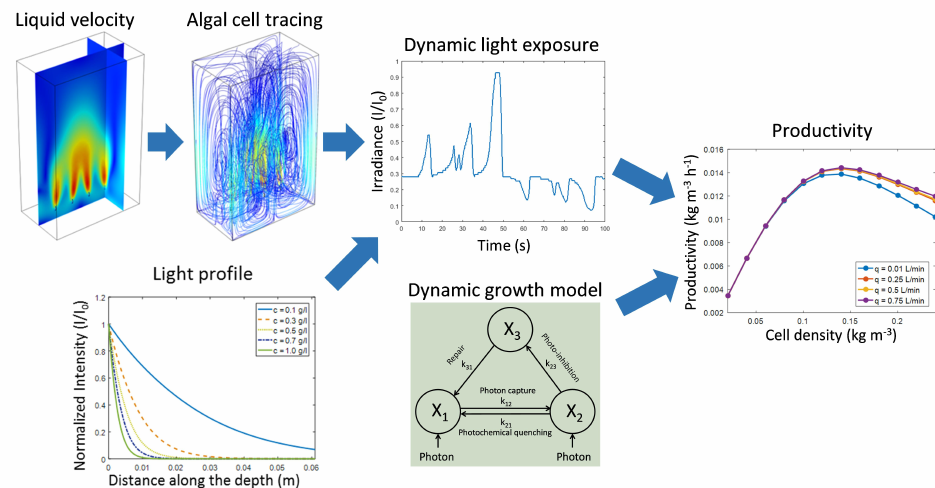
Figure 1. Schematic of workflow in the present study: liquid velocities obtained from CFD simulations of a PBR enabled calculation of flow profiles of many individual algal cells by particle tracing, which together with independently calculated light intensity profiles resulted in dynamic light exposure of individual algal cells. This was combined with growth modeling to obtain insights into the dependence of biomass productivity on operational